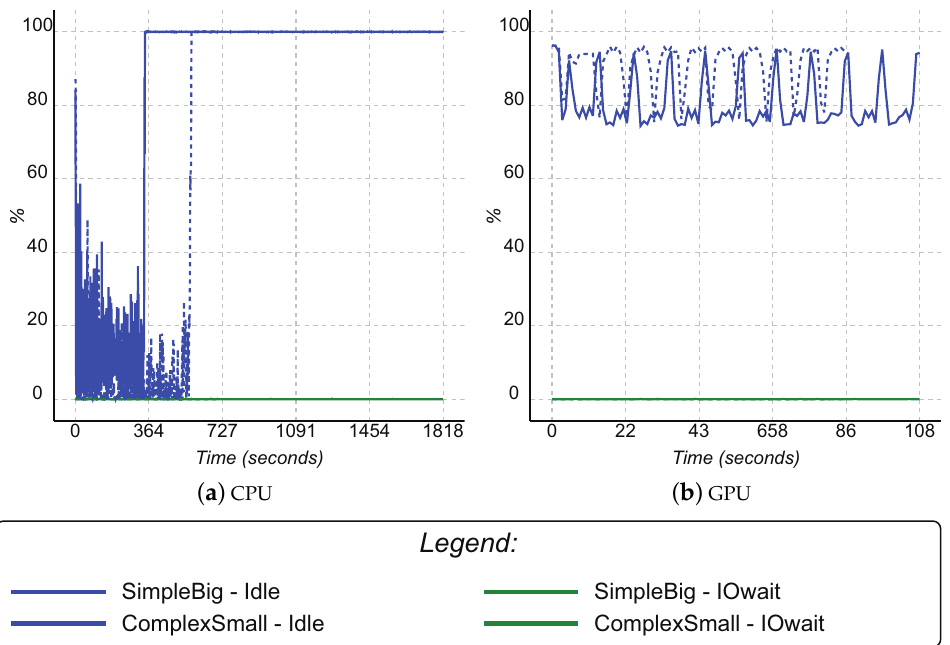
Figure 6. Resource utilization rates on the MPI distributed version. The x-axis shows the time (seconds) and the y-axis shows the percentage of time that the CPU is inactive in blue, the CPU was idle during which the system had an outstanding disk I/O request in green. The SimpleBig use case is shown in solid lines, and the ComplexSmall use case is shown in dashed lines. ( a ) shows the results of the setup running on the CPU, while ( b ) shows the results on the